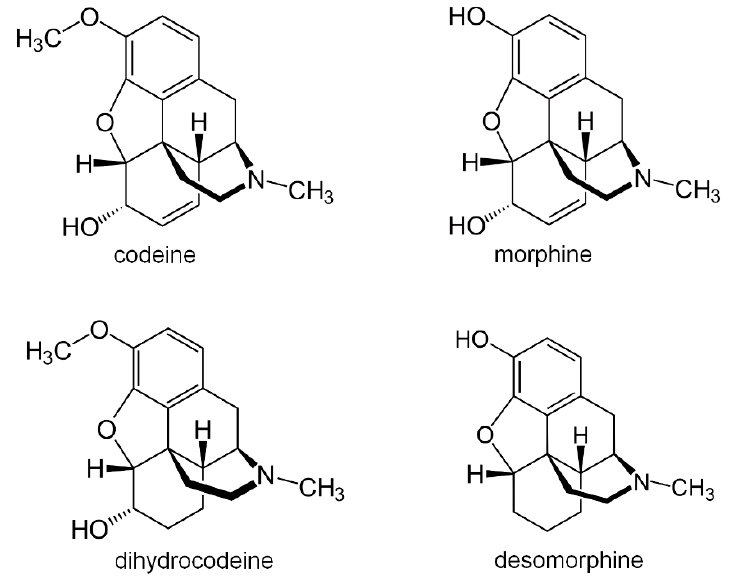
Figure 2. Chemical structures of selected opioid drugs.